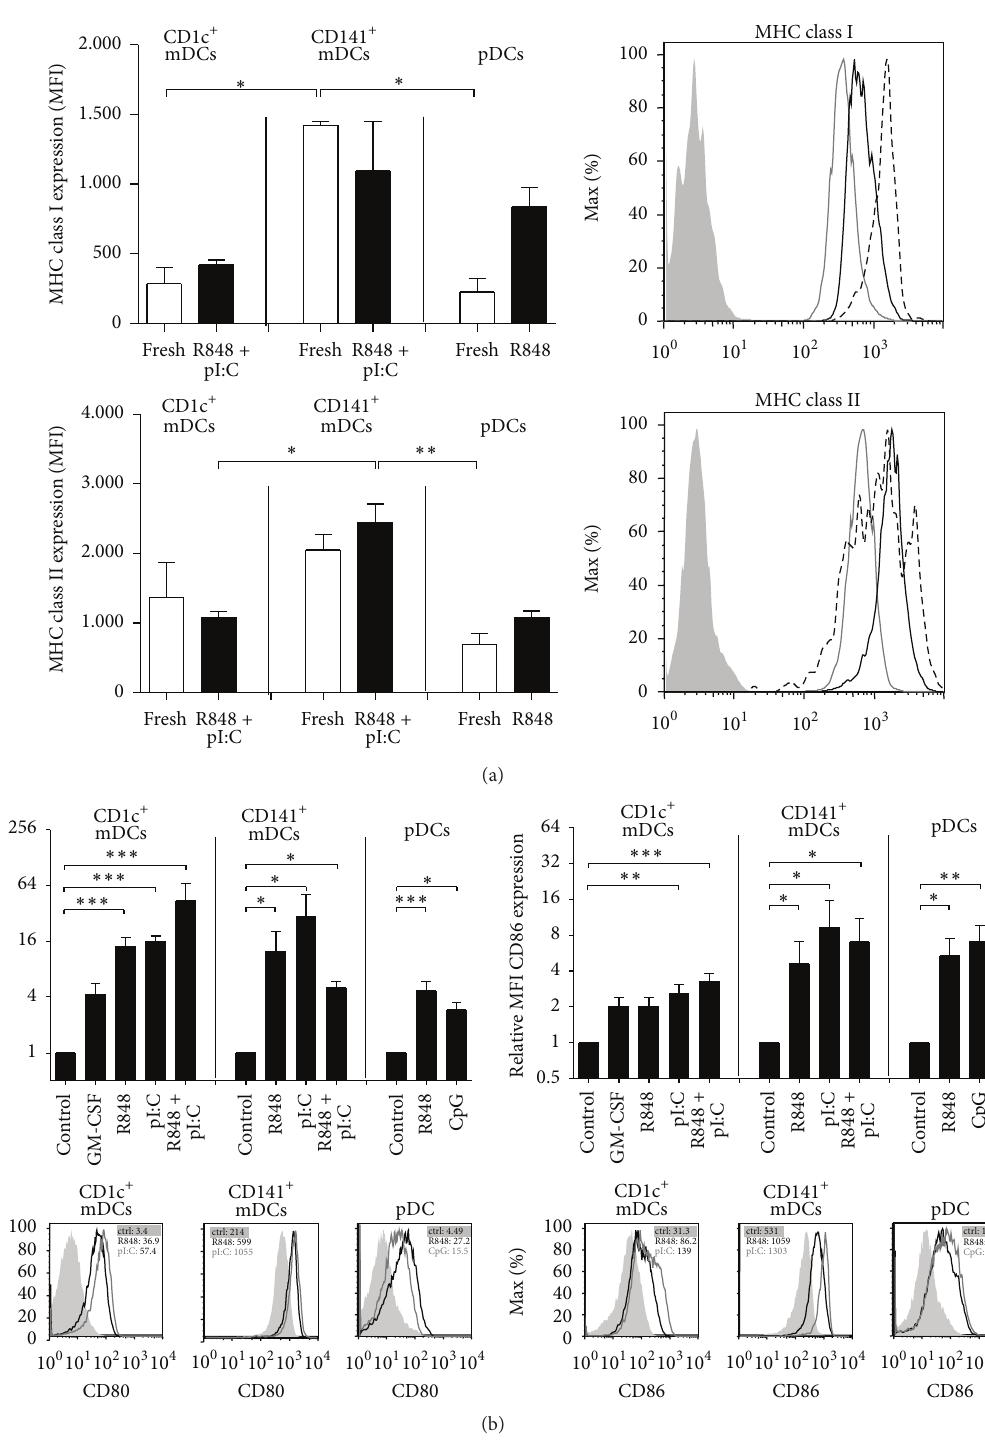
Figure 1: Phenotype of human blood DCs upon TLR stimulation. (a) MHC class I (HLA-ABC) and MHC class II (HLA-DR) expression was analyzed by flow cytometry of DCs kept at 4 ∘ C or DCs stimulated and cultured overnight. Myeloid DCs were stimulated with R848 and polyI:C (pI:C), whereas pDCs were stimulated with R848 alone. The bar graphs show the mean ± SEM of the mean fluorescent intensity (MFI) ( 𝑛 ≥ 3 ) and the histogram shows expression of freshly isolated DC subsets from a single representative donor (filled histogram: isotype control; grey line: pDCs, black line: CD1c + mDCs, dashed line: CD141 + mDCs). (b) The bar graphs (upper panel) show the fold change ± SEM of the MFI for surface expression of the costimulatory molecules CD80 and CD86 after overnight stimulation with reference to cells cultured in medium alone (or IL-3 for pDCs) ( 𝑛 ≥ 4 ). The histograms (lower panel) show CD80 and CD86 expression from a single representative donor (insets: MFI values). Significance was determined by Kruskal-Wallis test followed by Dunn’s testing comparing different conditions of the same subset ( ∗ 𝑃 < .05 ; ∗∗ 𝑃 < .01 ; ∗∗∗ 𝑃 < .001